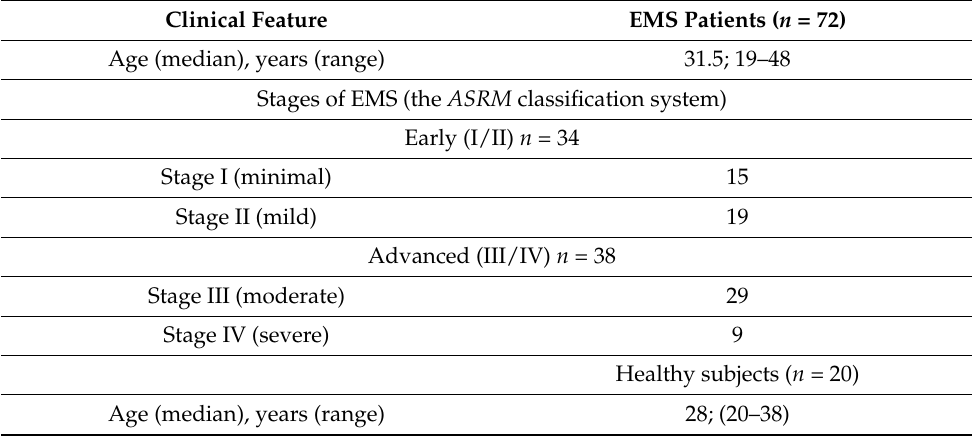
Table 2. Clinical characteristics of the EMS patient